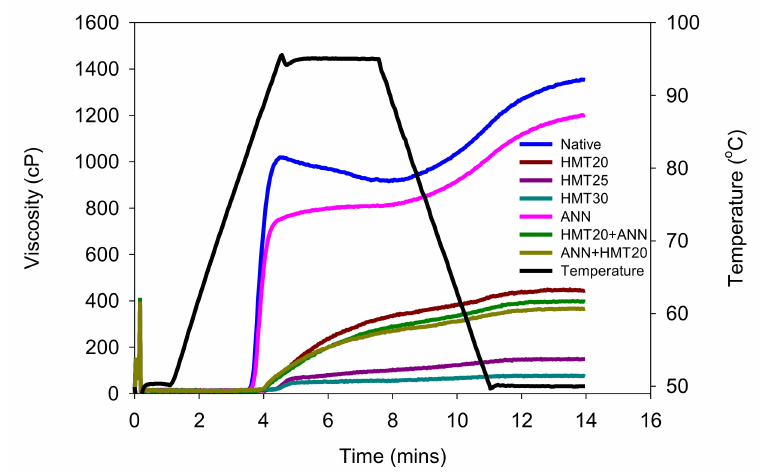
Figure 2. Effect of various hydrothermal treatments on the rapid-visco properties of water caltrop starch. Sample codes refer to Figure